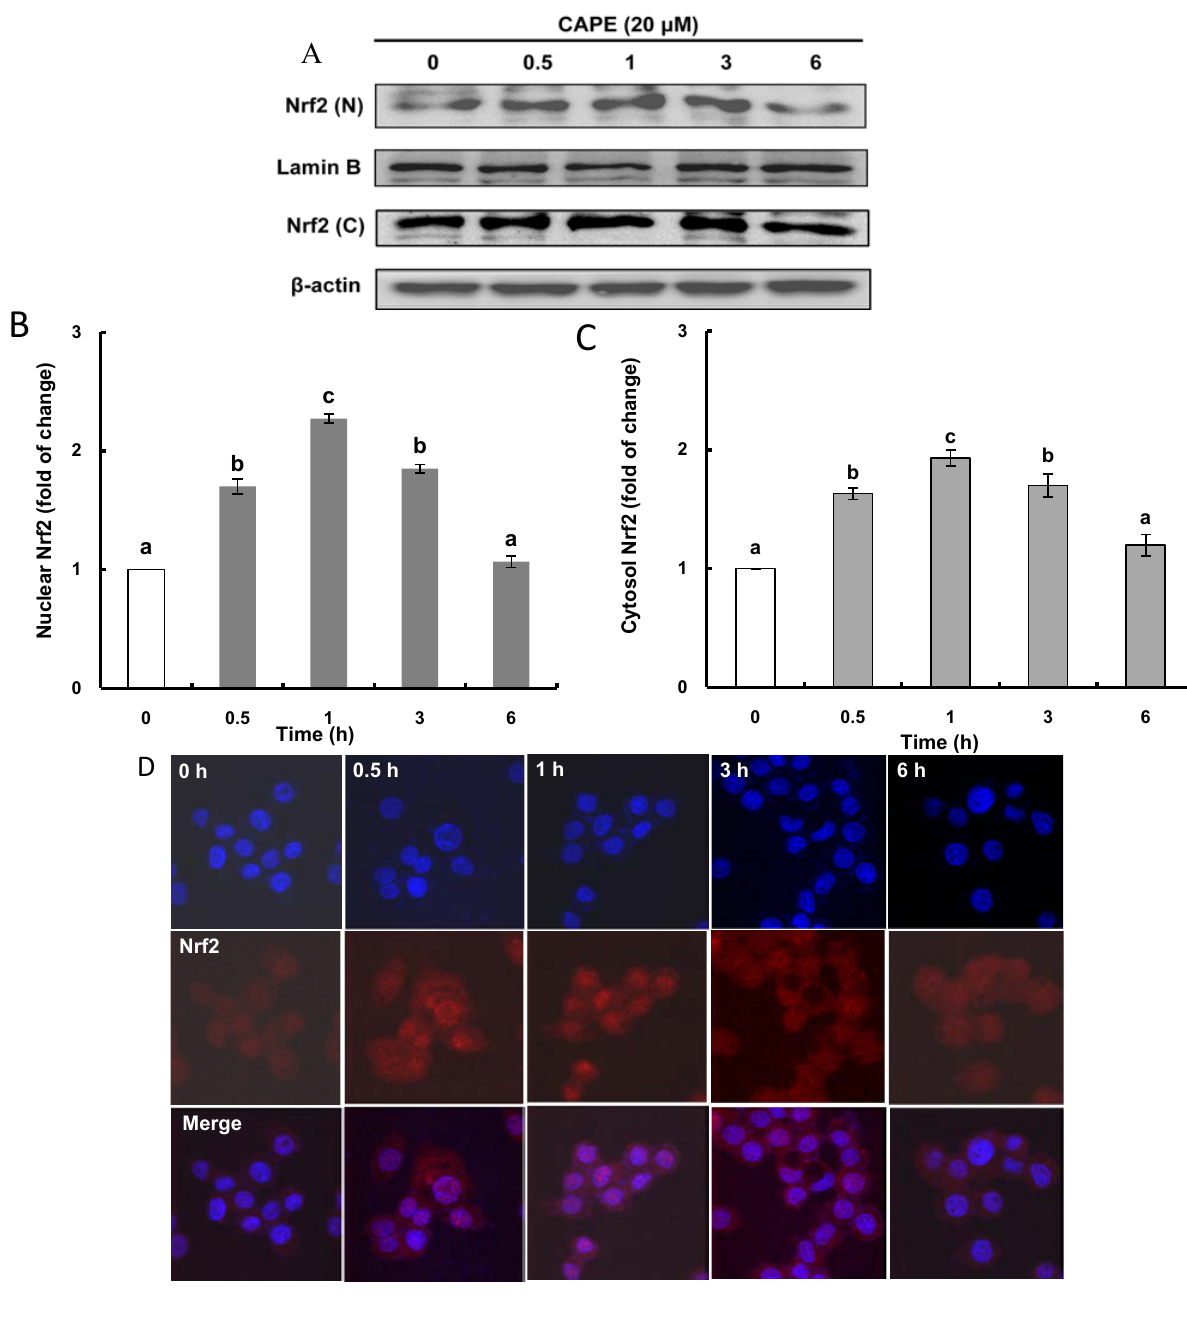
Figure 3. CAPE increases Nrf2 (nuclear transcription factor-erythroid 2-related factor 2) level in the nucleus and the cytosol. ( A ) After HepG2 cells were incubated with 20 μM CAPE for 6 h, the time-course induction of Nrf2 protein levels in the nucleus and the cytosol was determined using western blot analysis and normalized to time zero; ( B ) Time-course change of Nrf2 protein level in the nucleus; ( C ) Time-course change of Nrf2 protein level in the cytosol; and ( D ) Immunofluorescence staining of HepG2 cells subjected to 20 μM CAPE as indicated with anti-Nrf2 antibodies. Nuclear counterstaining was done with Hoechst 33528 (Sigma Aldrich, St. Louis, MO, USA). Fluorescence image was taken by confocal fluorescence microscopy. Data are expressed as mean ± standard deviation of three individual experiments. Different corresponding letters indicate significant differences at p < 0.05 by Duncan’s